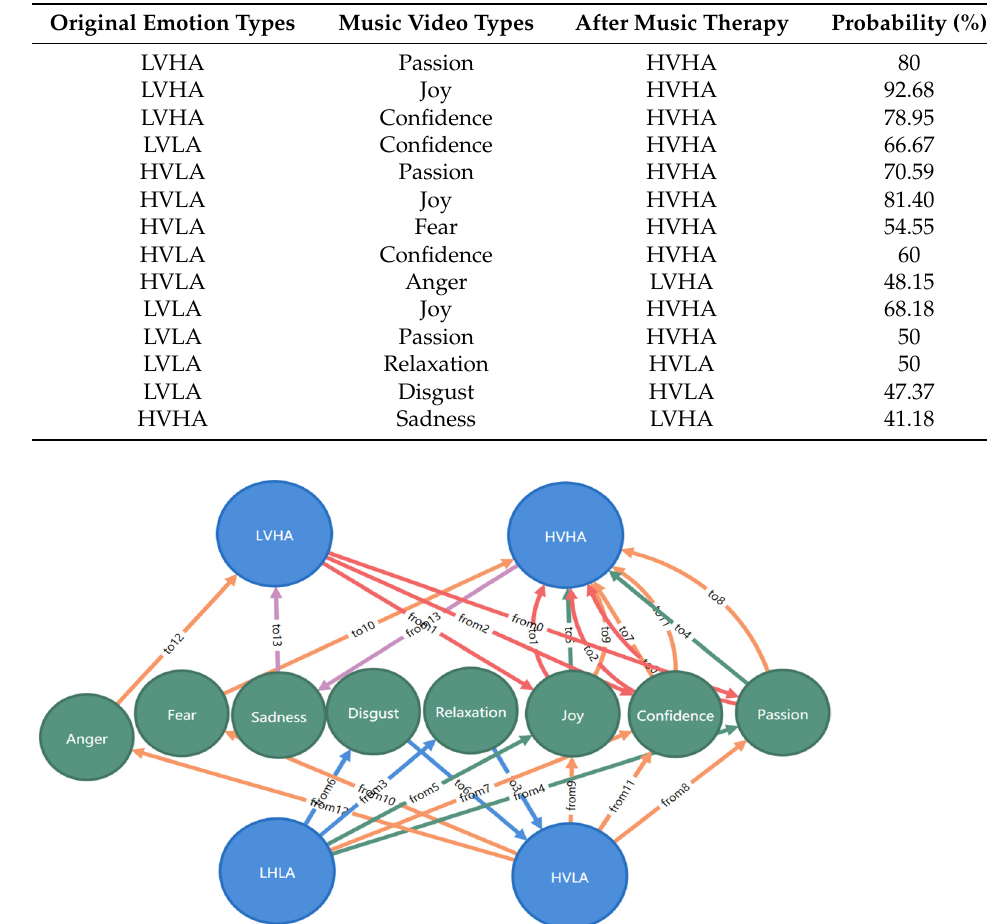
Table 8. Video types and emotions relationship in valence-arousal model.